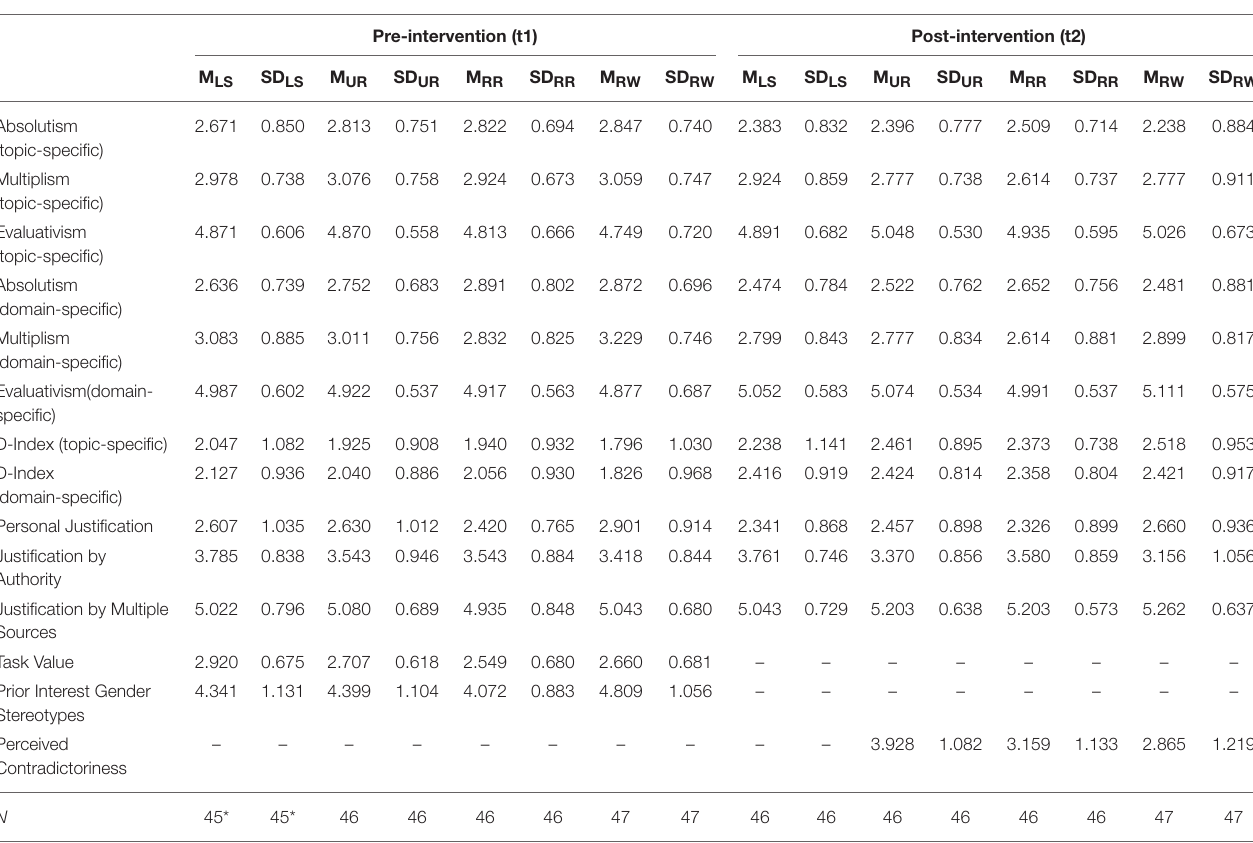
TABLE 3 | Means and standard deviations of all study variables separated by intervention